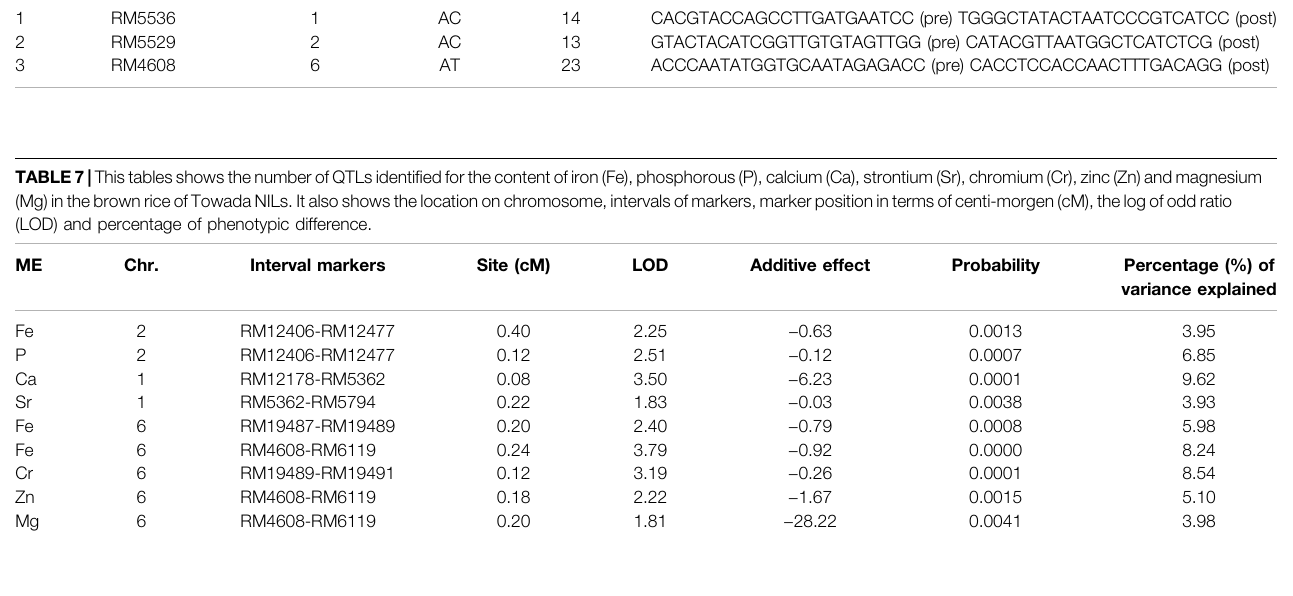
TABLE 6 | The location ofpolymorphic SSR markers on chromosome and the core sequence and number ofrepeats with fl anking regions ofthe polymorphic SSR markers (RM5536, RM5529, RM4608) used for primer synthesis. S. No.